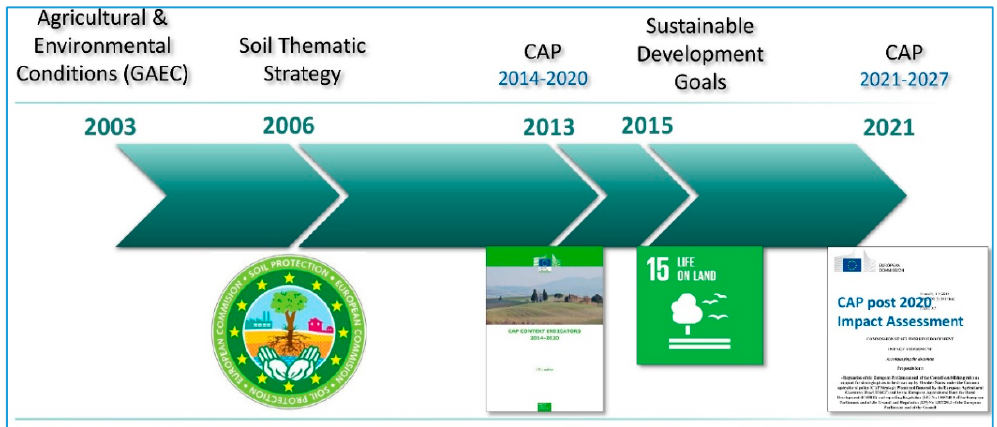
Figure 1. Policy development in the EU in relation to soil erosion reduction.